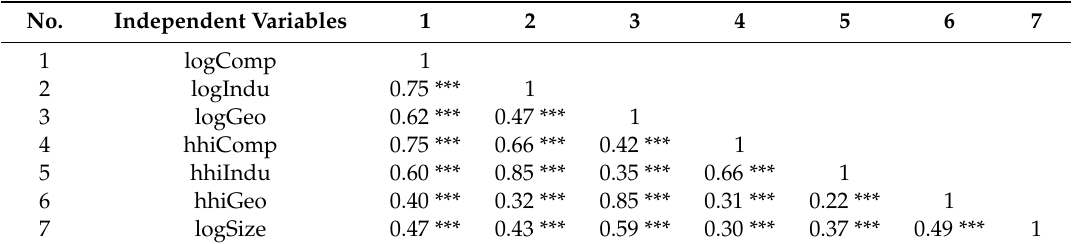
Table 2. Correlations of independent